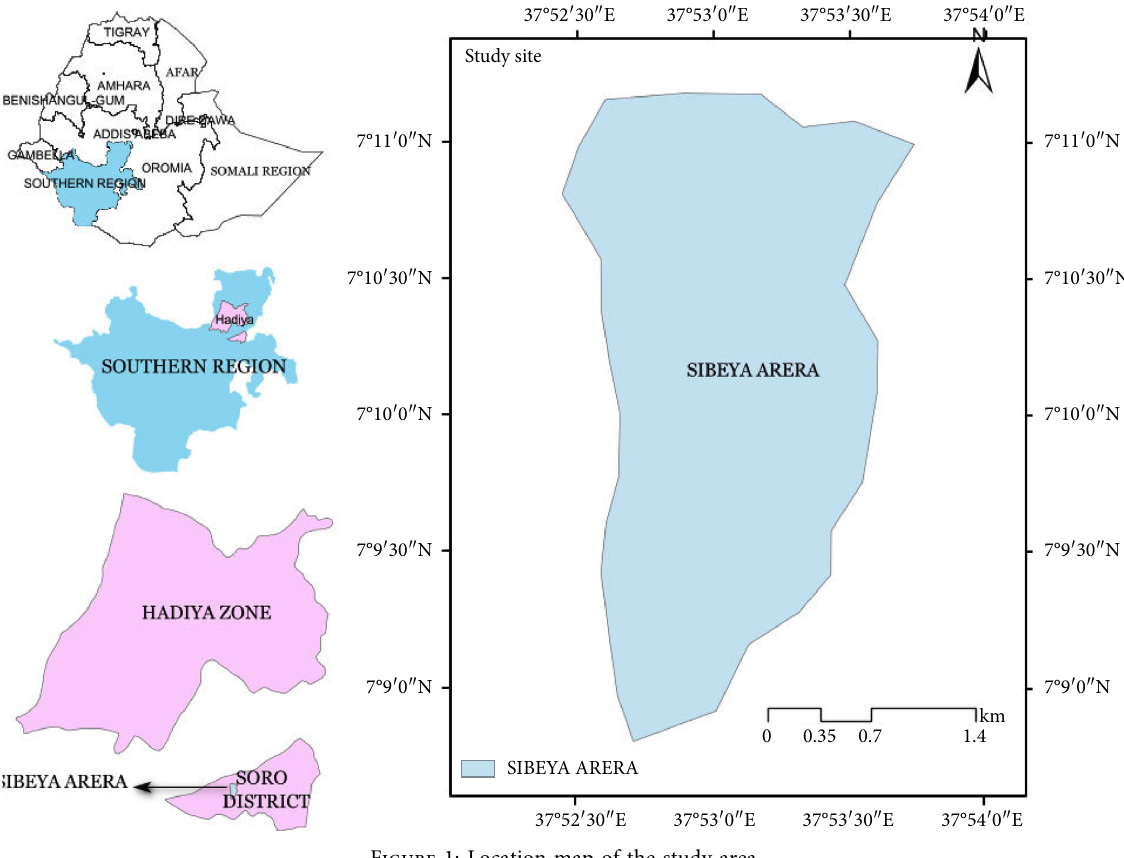
Figure 1: Location map of the study area.